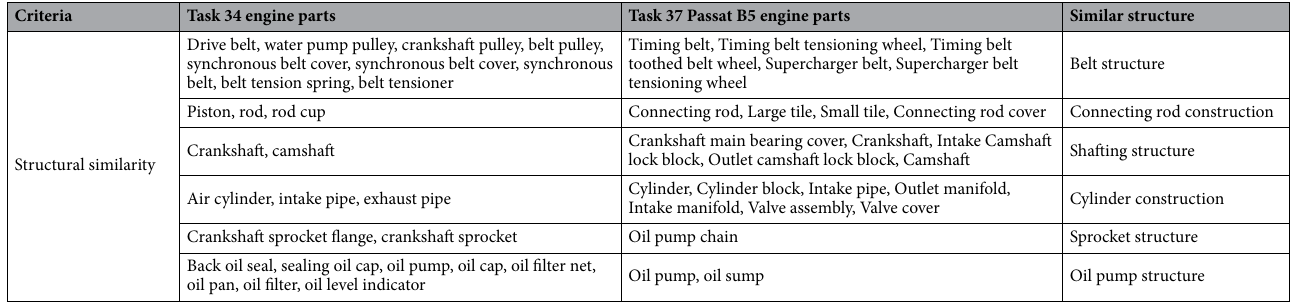
Table 4. Results of a similarity analysis of the two engines.